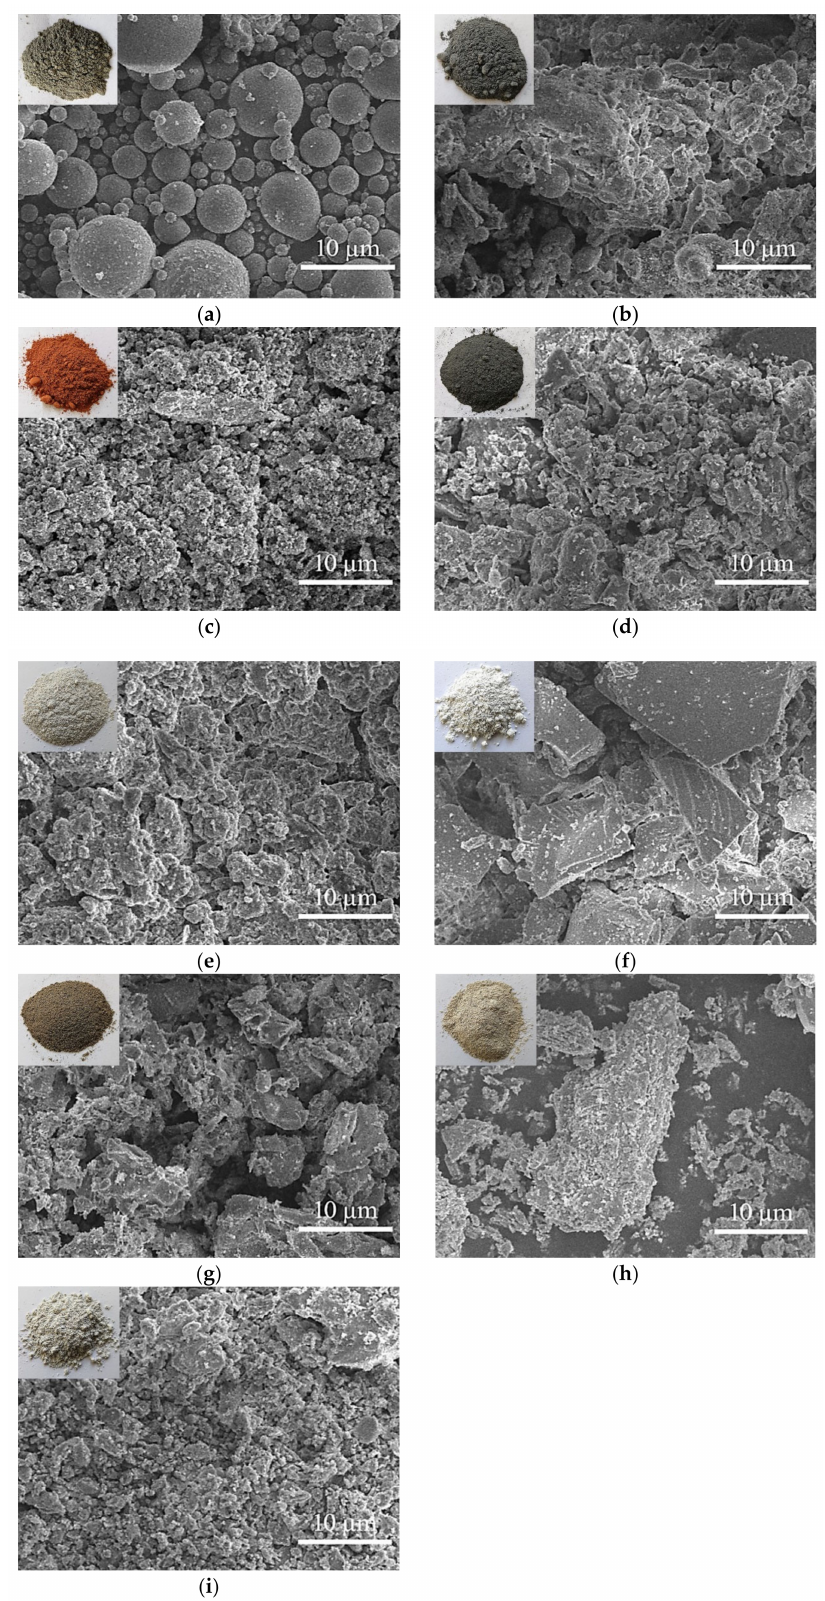
Figure 4. The SEM images of raw materials: ( a ) FAI, ( b ) FAII, ( c ) RM, ( d ) CS, ( e ) SR, ( f ) GBFS, ( g ) BRS, ( h ) GP, and ( i )